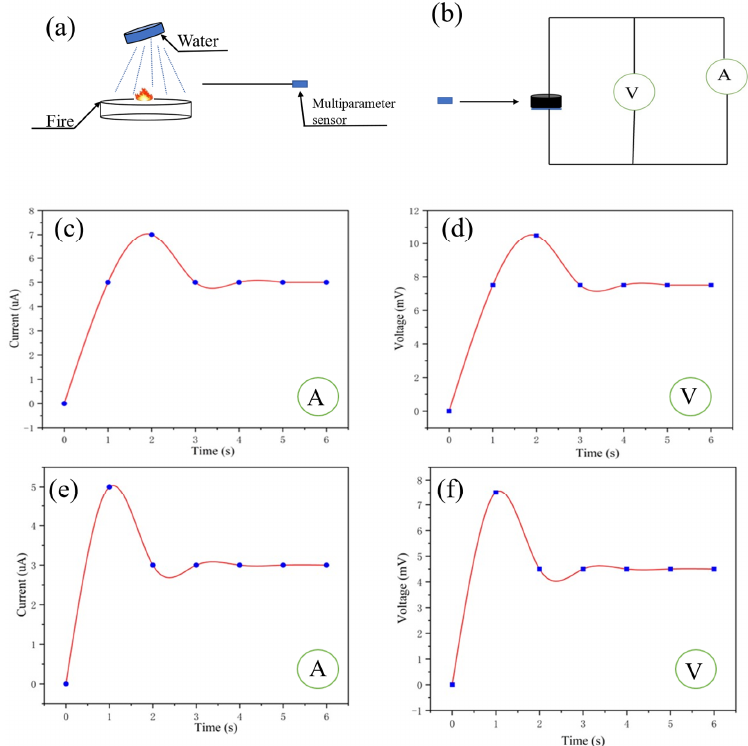
Figure 8. ( a , b ) Fire extinguishing sensing at a certain distance from the fire source by the multipa- rameter sensor; ( c , d ) ammeter and voltmeter readings of the sensor 10 cm away from the fire extin- guishing point; ( e , f ) ammeter and voltmeter readings of the sensor 30 cm away from the fire extin- guishing point.